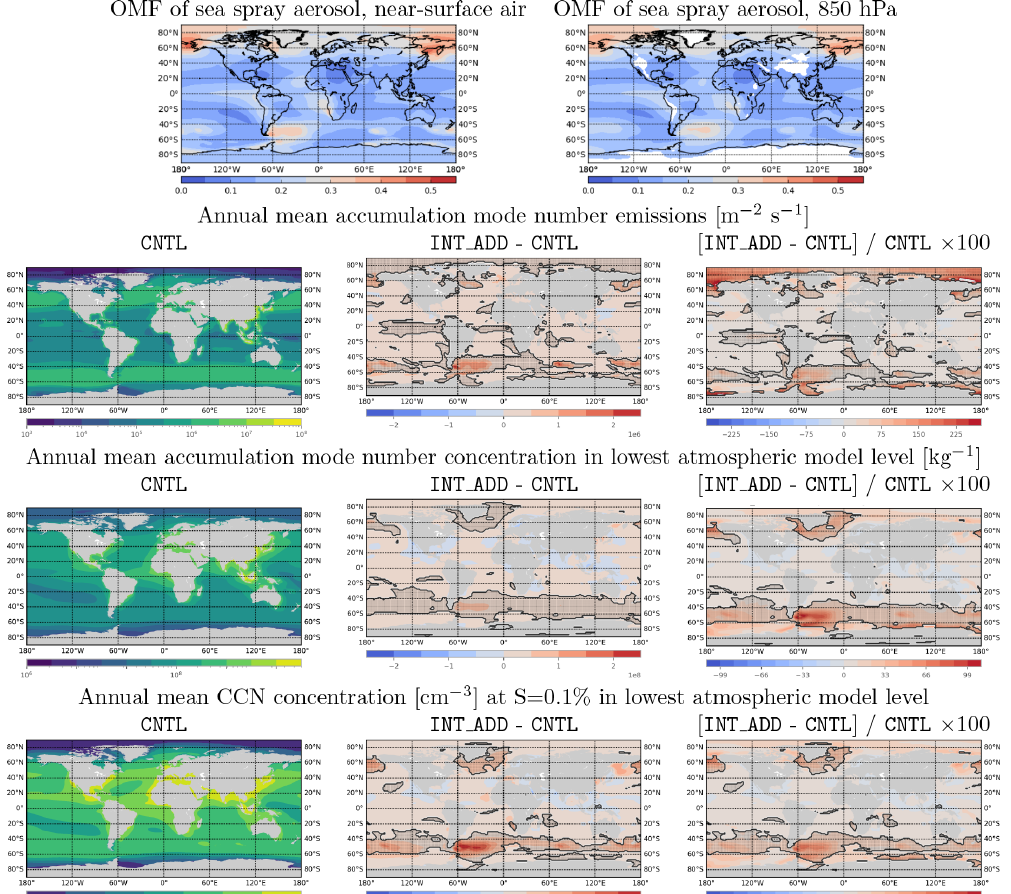
Figure 9. Annual mean modeled fields and changes in annual mean modeled fields due to introduction of MOA in the INT_ADD case. Shaded regions outlined with black contours indicate regions where absolute differences are statistically significant by Welch’s t test at the p < 0.1% level. White space indicates missing values; continents are shaded grey in the second through fourth rows. Top row: global annual mean organic mass fraction of accumulation-mode sea spray aerosol at the surface (left) and 850hPa (right). Second row: annual mean accumulation-mode number emissions (m − 2 s − 1 ) in CNTL (left) and absolute change (center) and percentage change (right) in INT_ADD . Third row: As above, for annual mean accumulation mode number concentration in lowest atmospheric model level [kg − 1 ]. Fourth row: As above, for annual mean CCN concentration (cm − 3 ) at S = 0.1% in the lowest atmospheric model level.